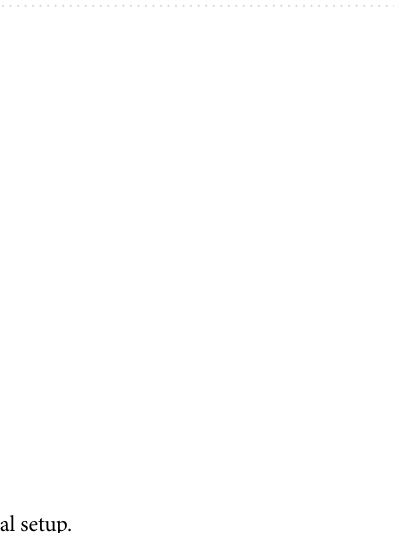
Figure 10. Suggested fabrication process flow for the proposed device.